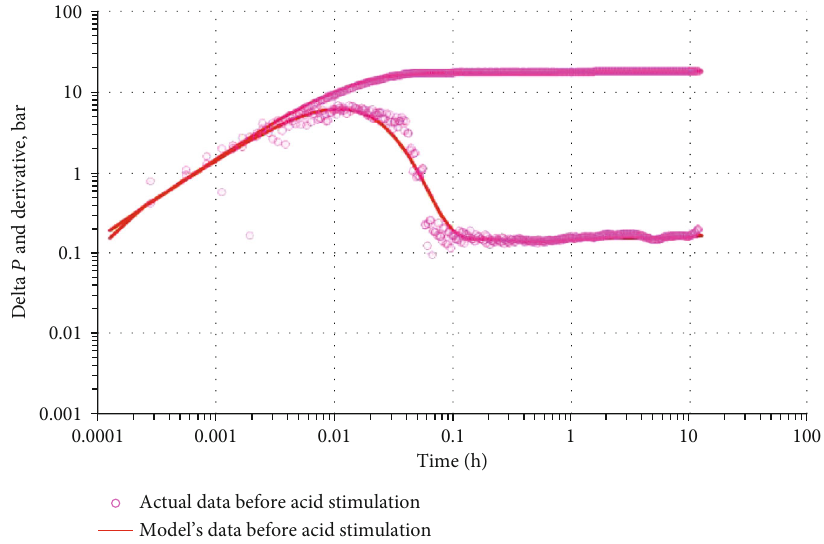
Figure 9: Interpretation chart of P-3 pressure buildup before acid